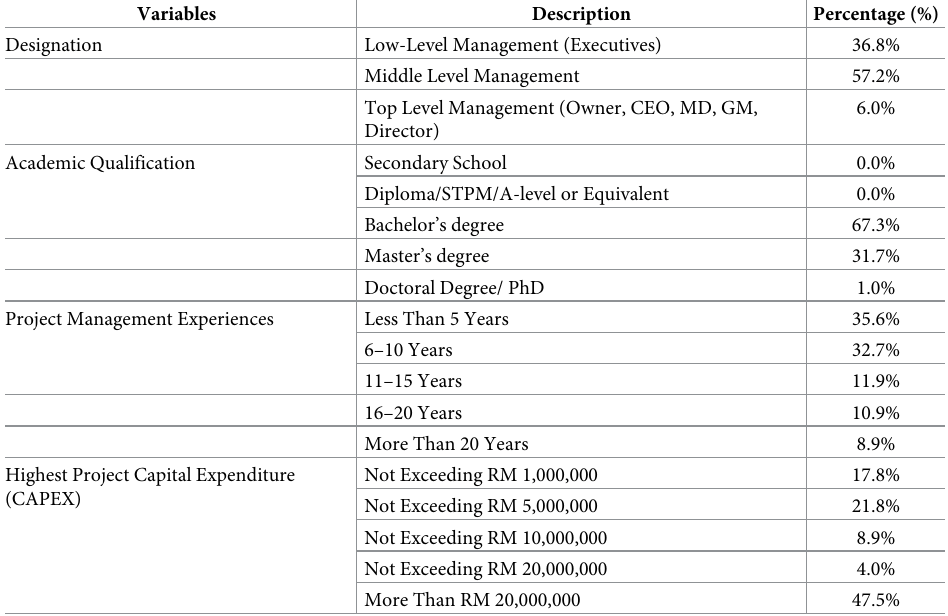
Table 1. Profile of